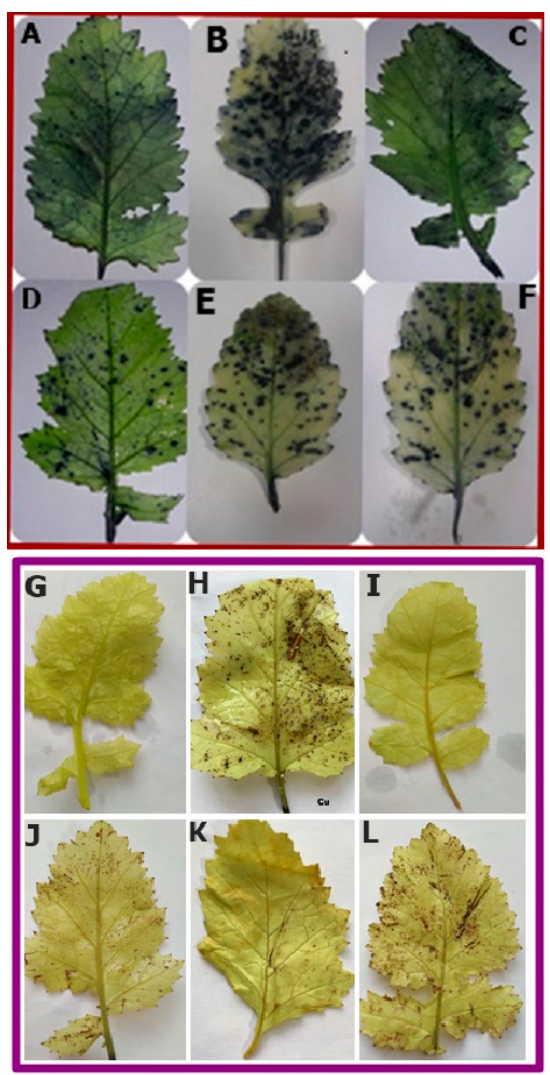
Figure 8. Accumulation of superoxide ion (O 2 − ) and H 2 O 2 in leaves of Indian mustard ( Brassica juncea L.) stained with NBT ( A – F ) and DAB ( G – L ) respectively at 30 DAG. Plants were grown with/without Cu stress and treated during pre-germination for 3 h with water, SNP, FCy (SNP analogue) and SNP + cPTIO (cPTIO as a specific NO-scavenger). Control: A and G ; B and H : Cu; C and I : SNP; D and J : SNP + Cu; E and K : FCy + Cu; F and L : SNP + cPTIO + Cu.